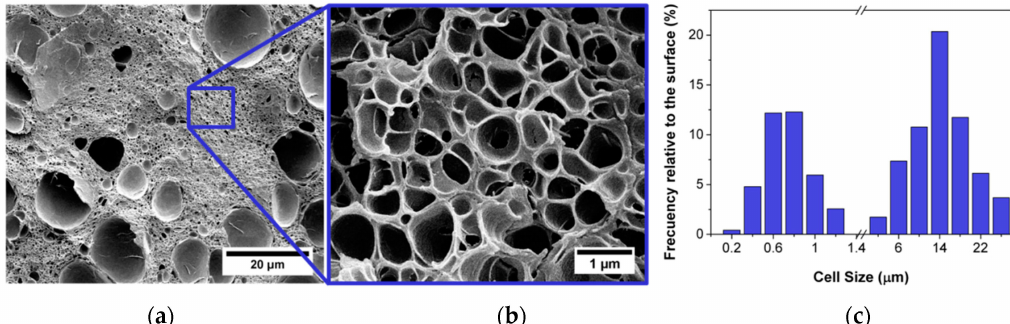
Figure 4. Bimodal distribution of the cell size observed for the blend of PMMA with a 0.5 wt.% of S-QAS. ( a ) General Image. ( b ) Zoom of the general image showing the nanostructure. ( c ) Cell size distribution diagram that has been calculated taking into account the different areas occupied by each population of cells (details can be found elsewhere